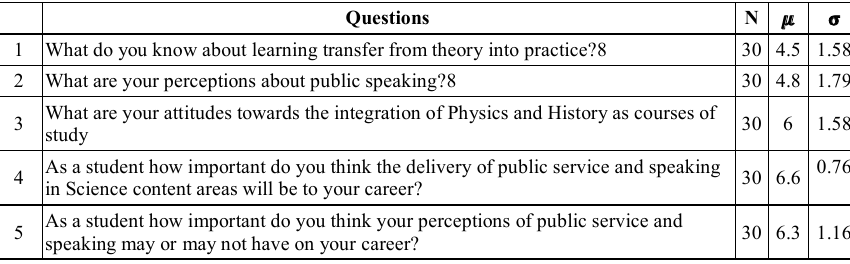
Table 3. Pre-Survey Questionnaire